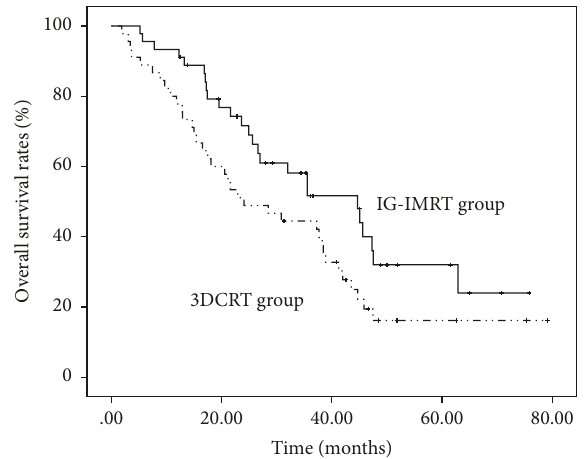
Figure 3: OS rates according to the modality of radiotherapy. Patients who received IG-IMRT showed longer median survival (44.7 versus 24.0 months, 𝑃 = 0.046 ) than patients who received